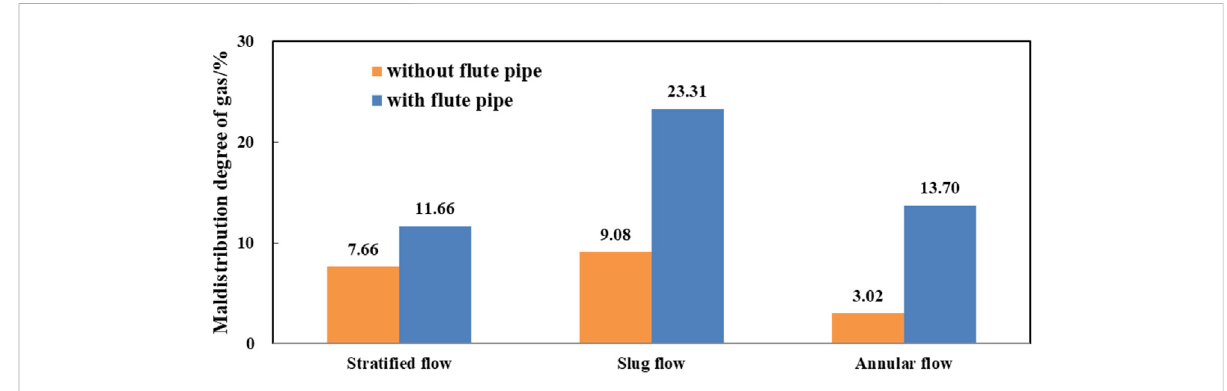
FIGURE 21 Histogram of fl ow pattern and average gas maldistribution degree in the horizontal